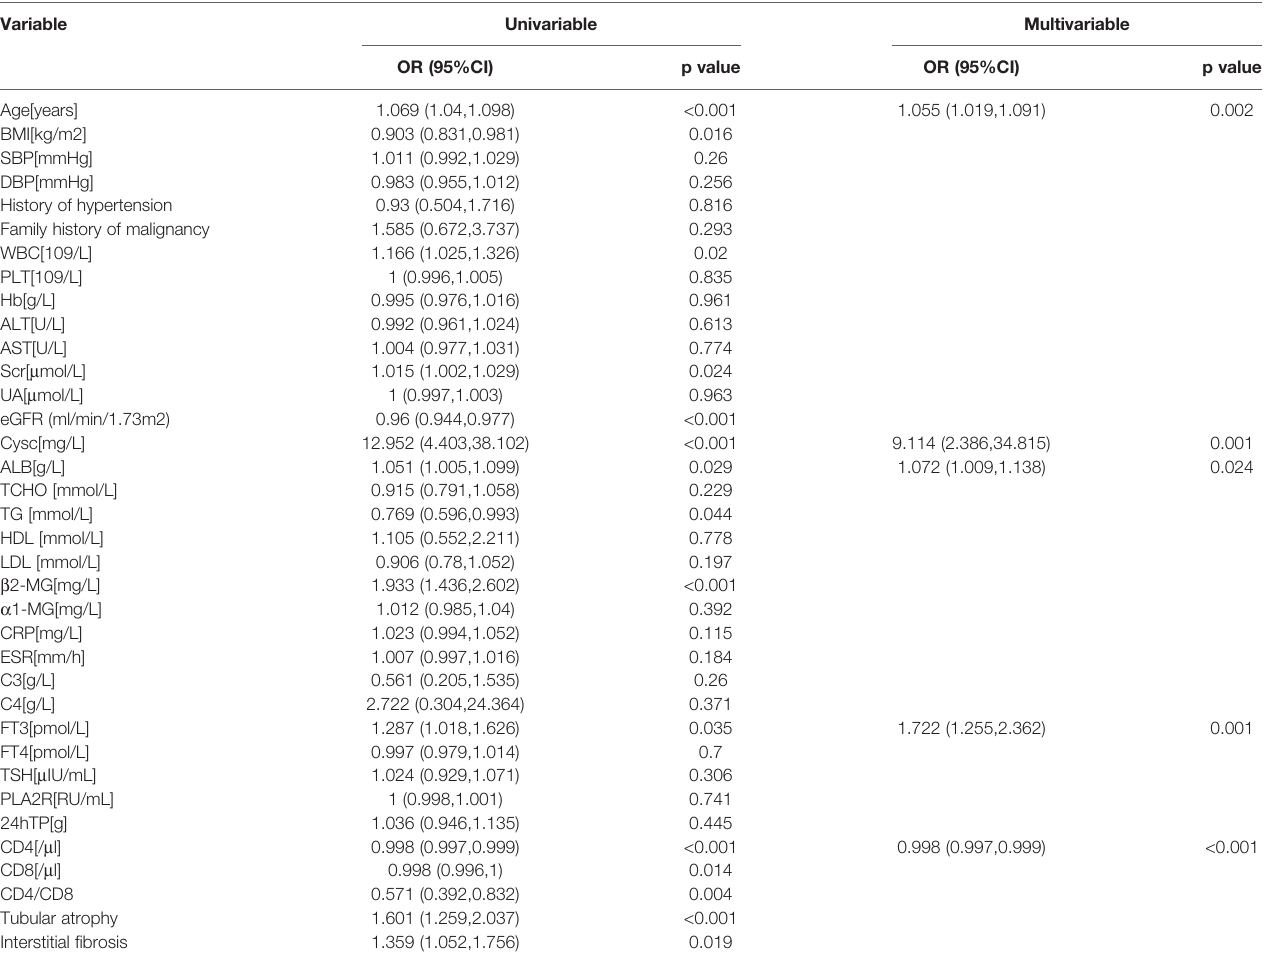
TABLE 6 | Identi fi cation of potential risk factors in MMN by univariate and multivariate regression analysis.